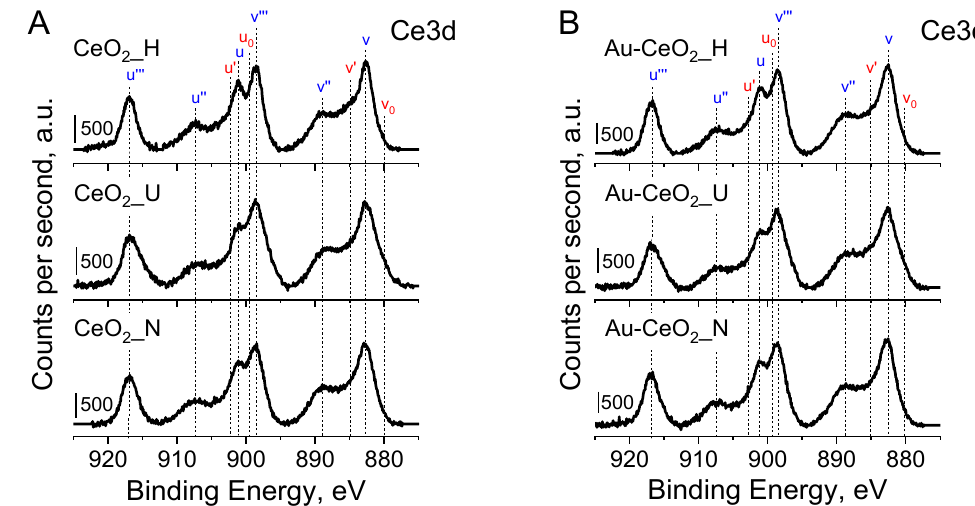
Figure 7. Ce 3d XP spectra of ceria supports ( A ) and gold catalysts ( B ).